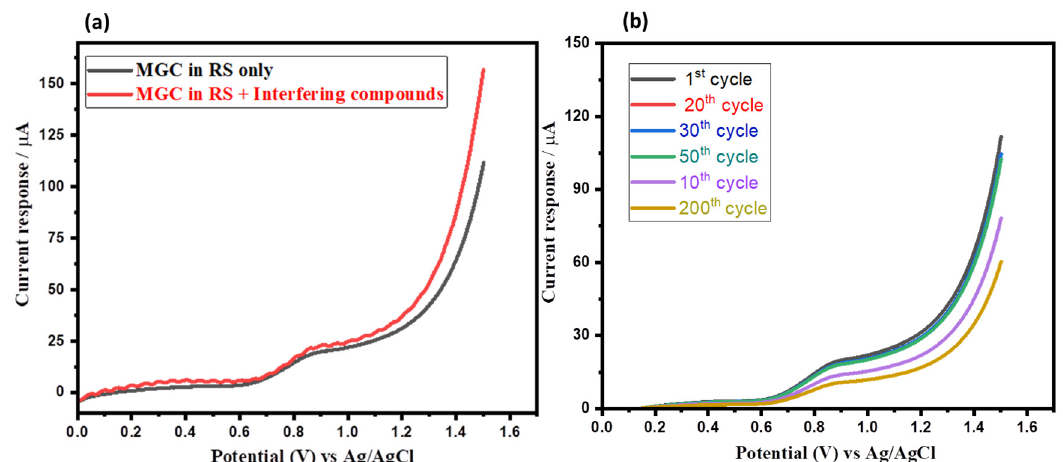
Figure 7. ( a ) LSV response of the MGC for 50 µ M RS and 50 µ M RS + 250 µ M interfering compounds (nitrophenol, glucose, urea, uric acid, catechol, hydrazine, hydrogen peroxide, ascorbic acid, and dopamine) at a scan rate of 50 mV/s. ( b ) LSV responses (1st, 20th, 30th, 50th, 100th and 200th cycle) of the MGC for 50 µM RS at a scan rate of 50 mV/s.